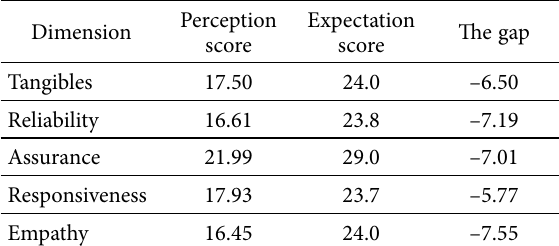
Table 3. The results of research on customers’